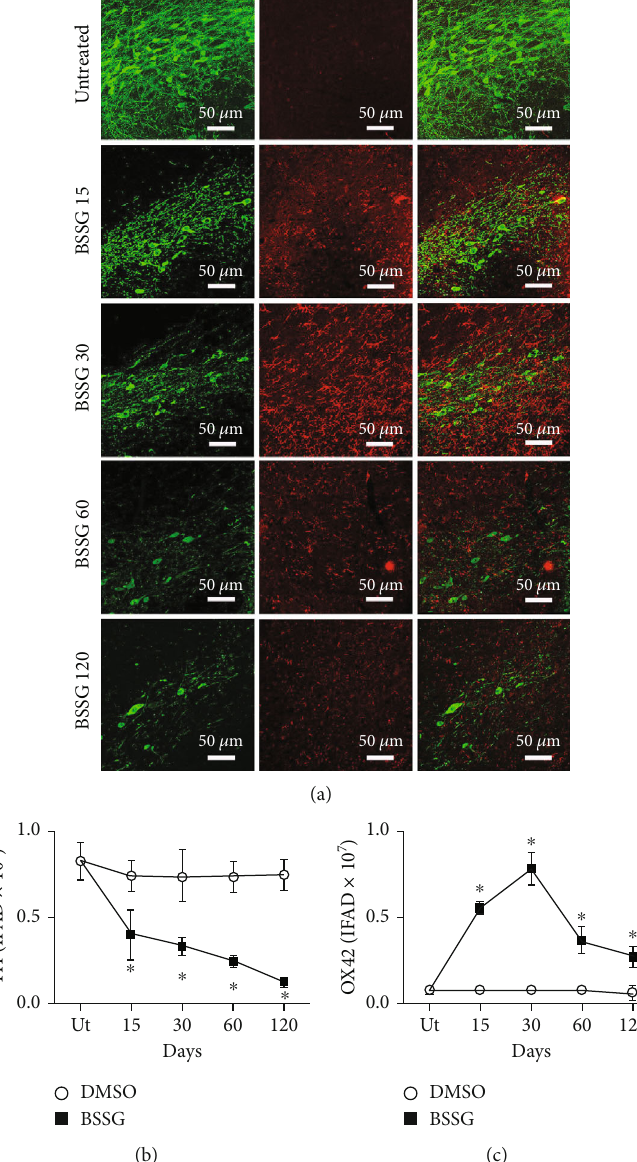
Figure 2: Time course of OX42 immunoreactivity after a BSSG injection in the SNpc. (a) Representative micrographs of the double immuno fl uorescence for TH and OX42 in untreated rats (Ut) and rats at di ff erent times (shown at the left side of micrographs) after BSSG injection. Immuno fl uorescence area density (IFAD) for TH (b) and OX42 (c) was determined using the ImageJ software v.1.46r (National Institutes of Health, Bethesda, MD). The TH and OX42 values for the mock rats correspond to the quanti fi cation in Supplementary Figure 2. The values are the mean ± SD from four anatomical levels. n = 3 independent rats in each time of each experimental condition. Two-way ANOVA and post hoc Bonferroni tests were applied for statistical analysis. ( ∗ ) indicates a P < 0 : 05 compared with the DMSO mock and Ut groups of the respective